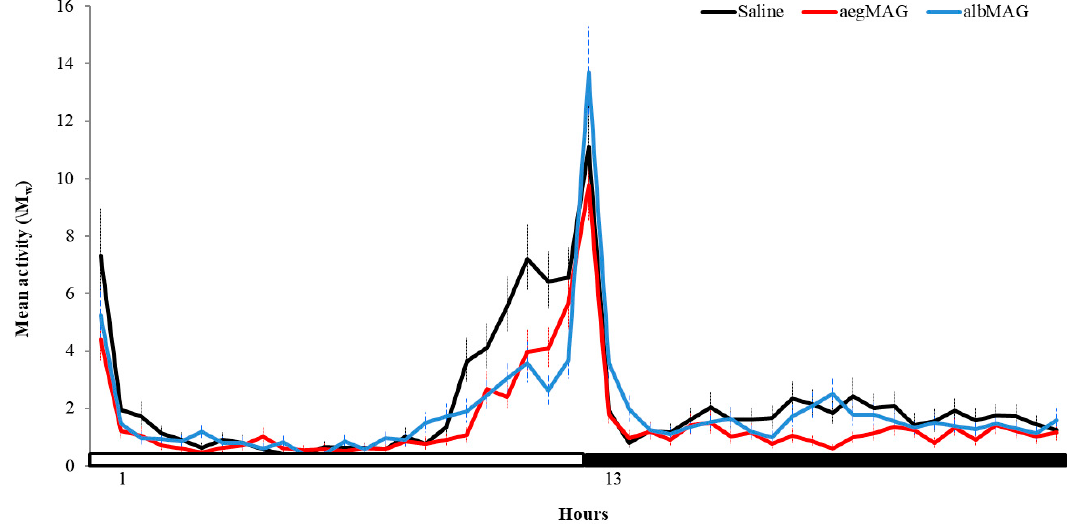
Figure 2. William’s mean (M w ) of locomotor activity of Aedes albopictus virgin females injected with saline (black line-control group; n = 63), MAG of Ae. aegypti (red line; n = 70) and MAG of Aedes albopictus (blue line; n = 74) under 12 h of light (white bar) and 12 h of dark (black bar) (light/dark 12:12) at 25 °C. Lines represent the 30 min mean activity (±standard error) of control and MAG-injected females in the four tested days.